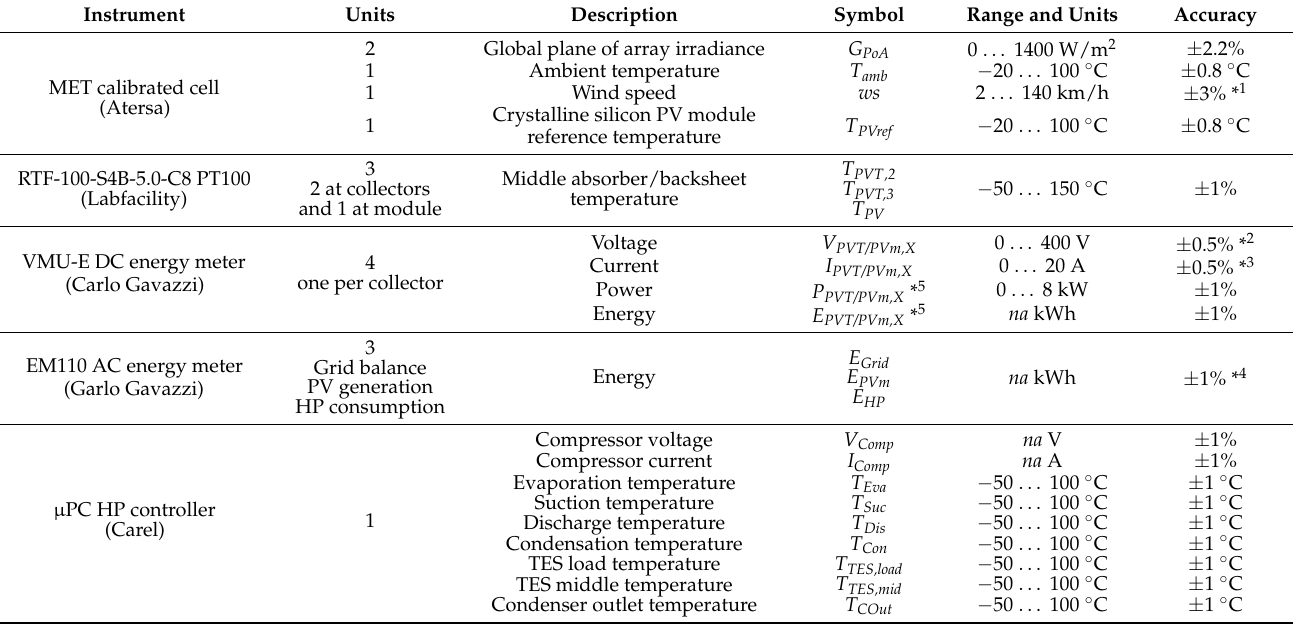
Table 4. A selection of the most significant monitored variables, including the instrument used for the measurement and some additional relevant information.